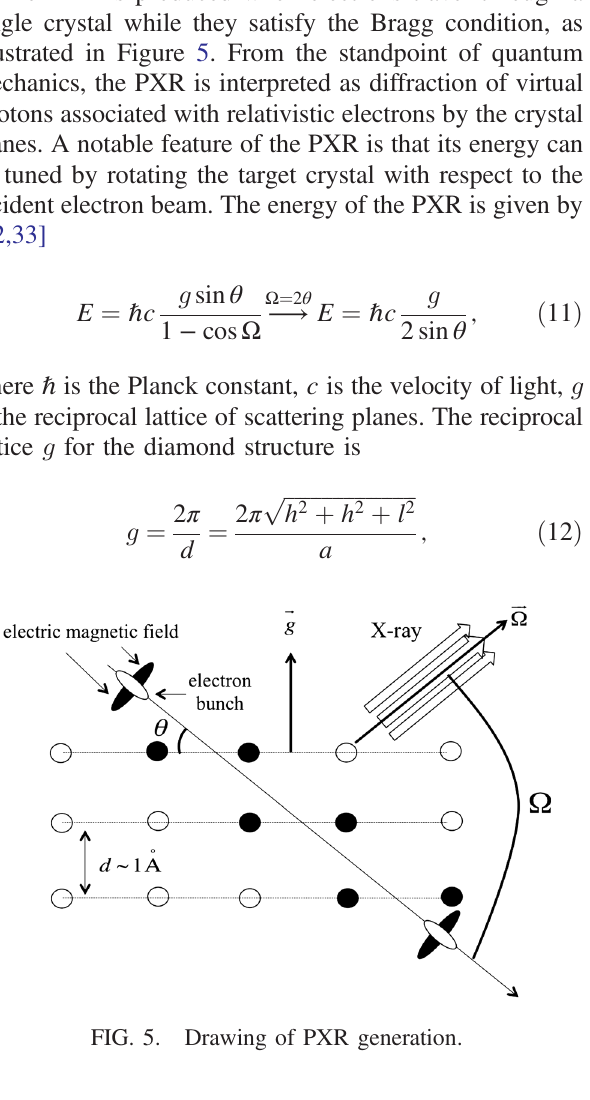
ffiffiffiffiffiffiffiffiffiffiffiffiffi p 1 − C 2